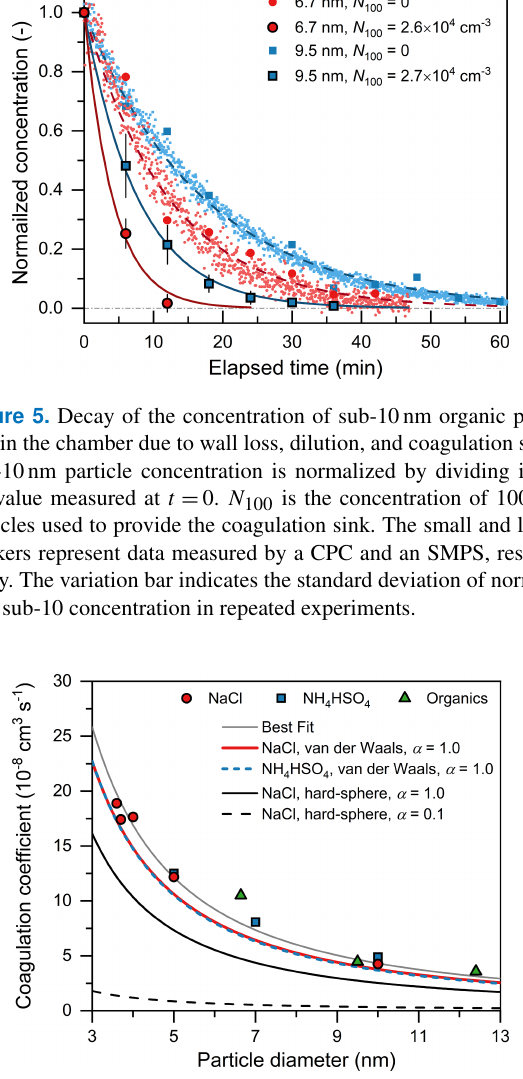
Figure 6. Measured and theoretical coagulation coefficients be- tween sub-10nm particles and 100nm particles. The hard-sphere coagulation coefficient only accounts for particle diffusion. The van der Waals coagulation coefficient also accounts for the van der Waals attractive force. α is the mass accommodation coefficient characterizing the effectiveness of coagulation. The best fit is ob- tained by fitting the best empirical Hamaker constant to the mea- sured size-dependent coagulation